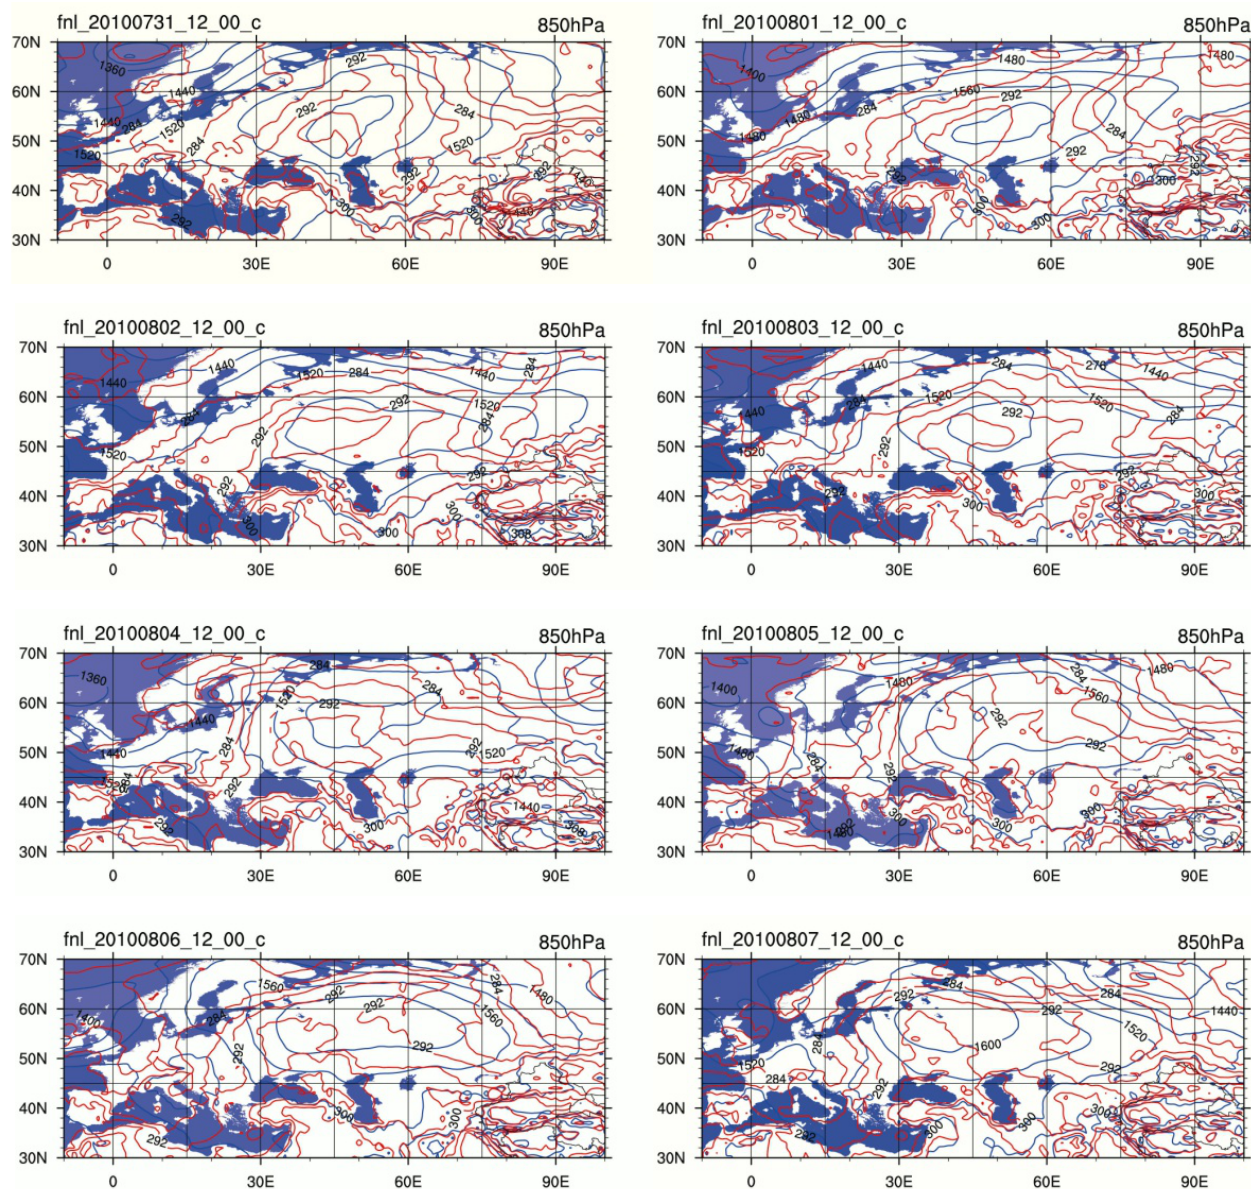
Fig. 3. Synoptic charts for the study area for each day at 12:00 UTC during the period from 31 July to 15 August 2010.